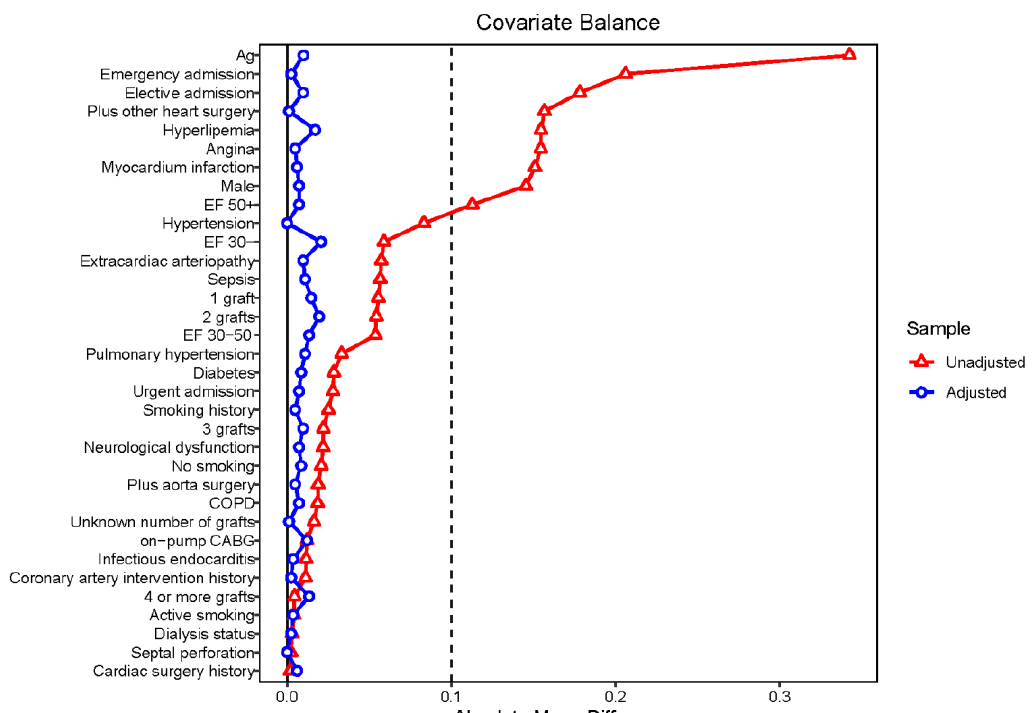
Figure 2. Balance of the matched cohort (love- plot generated by “cobalt” R package).